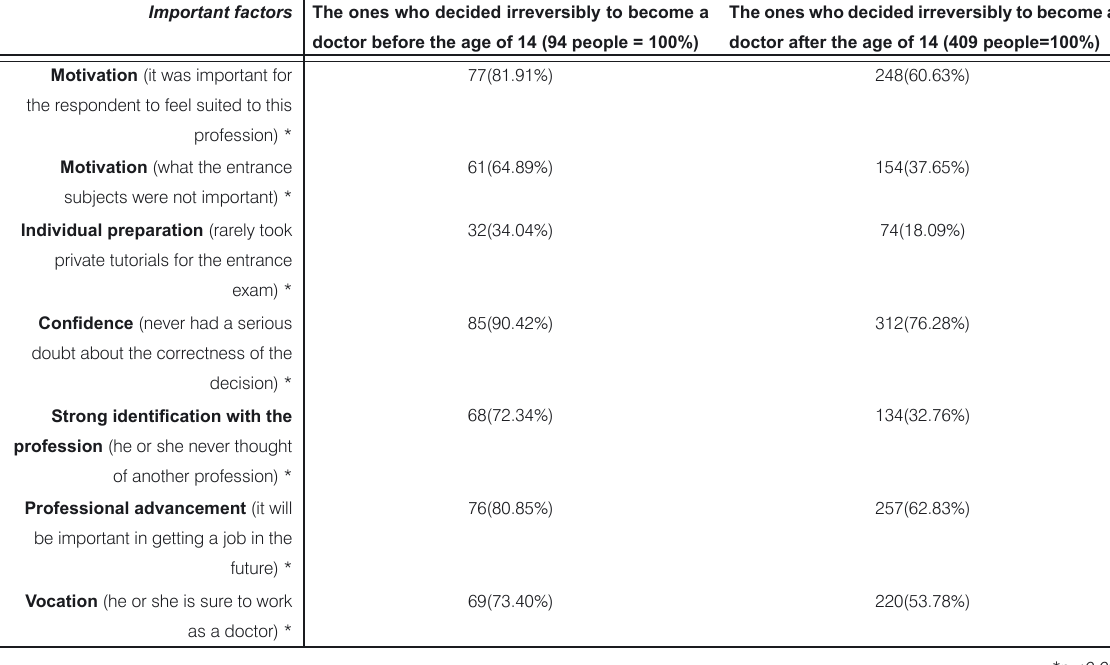
Table 5. The most significant differences between the students regarding the date of the final decision (n=503).